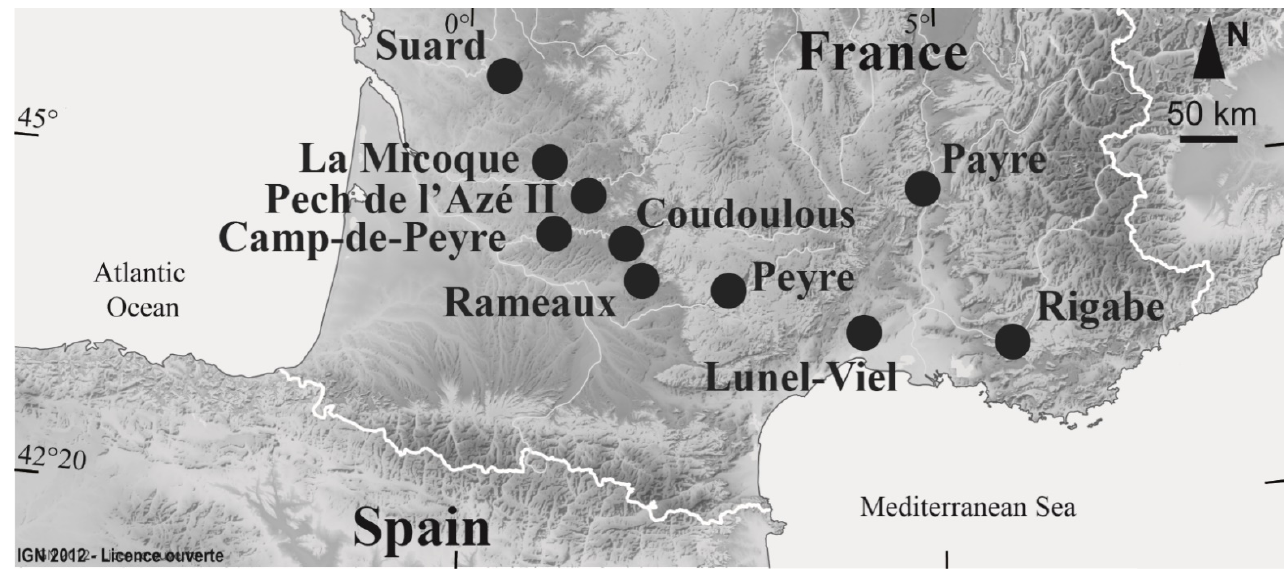
Figure 1. Location of the sites from the South West and South East of France selected for this study: Camp-de-Peyre, La Micoque, Rameaux, Lunel-Viel, Payre, Rigabe, Suard, Pech de l’Azé II, Coudoulous II and Peyre. Map: IGN 2012_Licence ouverte, modified A. Uzunidis (http://education.ign.fr/primaire/fonds-de-cartes (accessed on 20 May 2018)). Table 1. Localities cited in this study with dating, location, location of the collection and enumeration of the bones and teeth studied. MMSH: Maison Méditérranéenne des Sciences de l’Homme; MNP: Musée National de Préhistoire. MIS 12: ca 478-424 ky; MIS 10: ca 374-337 ky; MIS9: ca 337-300 ky; MIS 7: ca 243-191 ky; MIS6: ca 191-130 ky; MIS 5: ca 130-71 ky (age interval for each isotopic stage in [22]). Reference Locality Region Age for Dating